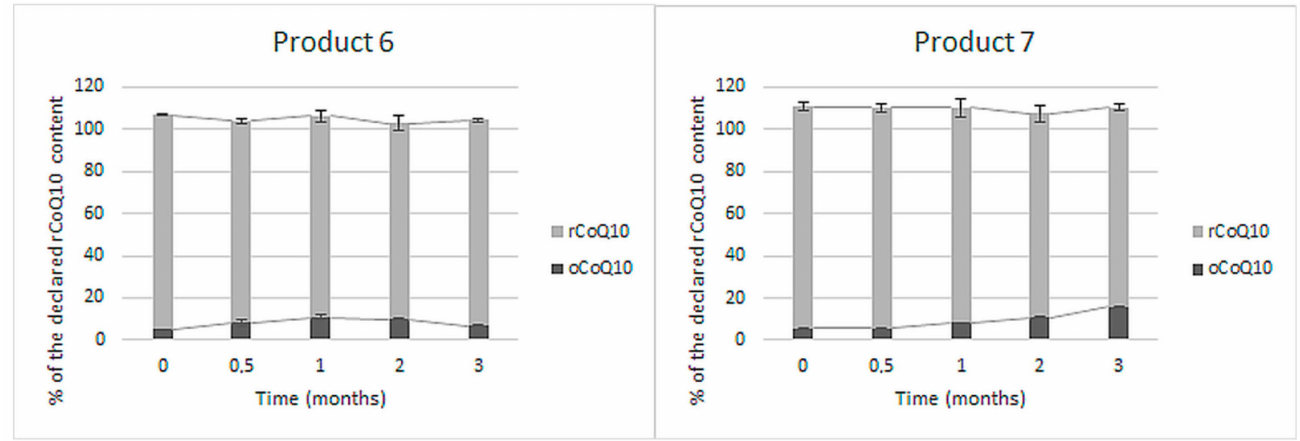
Figure 2. The stability of rCoQ10, oCoQ10, and total CoQ10 in the two tested finished products with specified rCoQ10 content after the accelerated stability study.